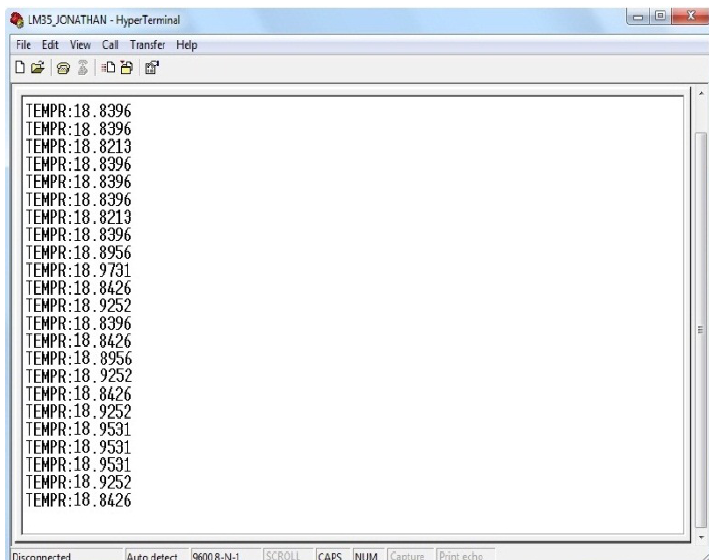
Figure 11. Data detection with